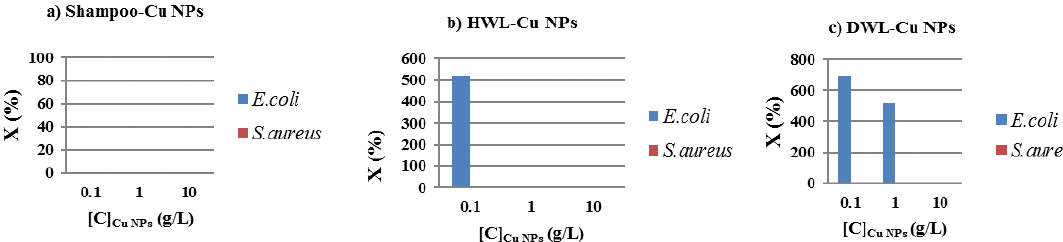
Fig. 3. Percentage growth of bacteria vs. concentration of copper nanoparticles (Cu NPs) a) shampoo, b) HWL, and c) DWL samples.